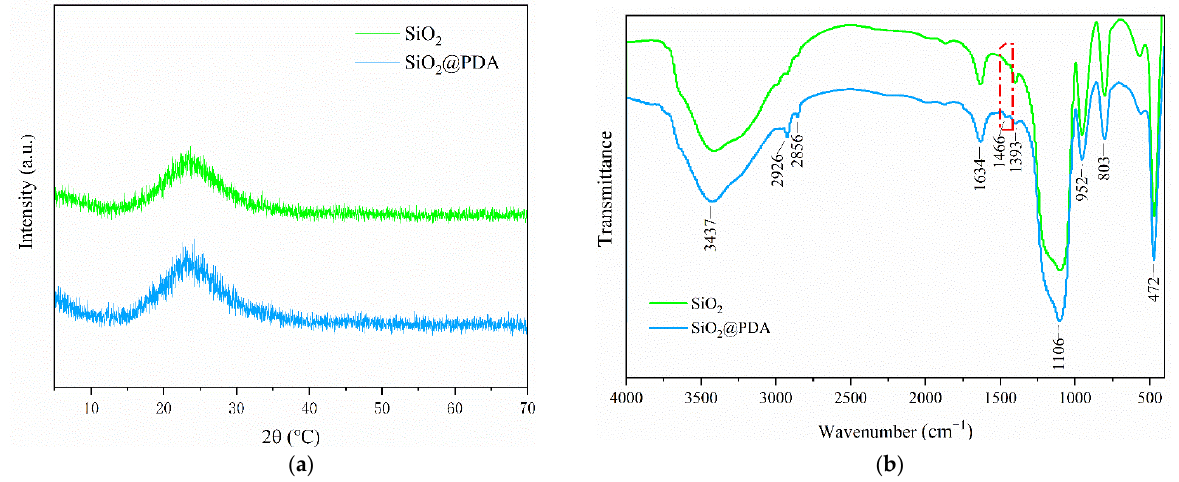
Figure 2. ( a ) XRD images of SiO 2 and SiO2@PDA microspheres. ( b ) FT-IR spectra of SiO 2 and SiO 2 @PDA microspheres.